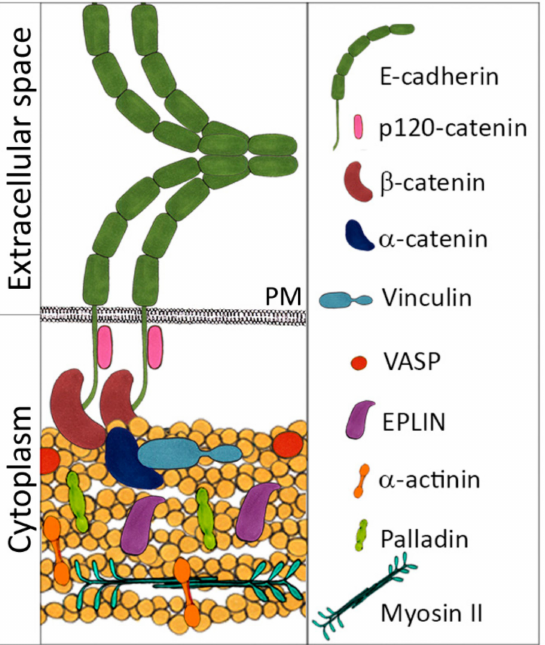
Figure 2. Structure and composition of an epithelial adherens junction. E-cadherin molecules (green) on the surface of adjacent cells connect with one another via their extracellular domains. Below the cytoplasmic membrane (PM), the intracellular domain of E-cadherin interacts with p120 (pink) and β -catenins (dull red). β -catenin binds to α -catenin (dark blue), which, in turn, interacts with vinculin (blue) and directly with actin filaments (yellow). Vinculin binds to actin filaments to stabilize the cadherin-catenin complex. Various actin-binding proteins such as VASP (bright red), EPLIN (Epithelial Protein Lost in Neoplasm) (purple), α -actinin (orange), palladin (light green) and myosin II (cyan-green) are associated with junctional